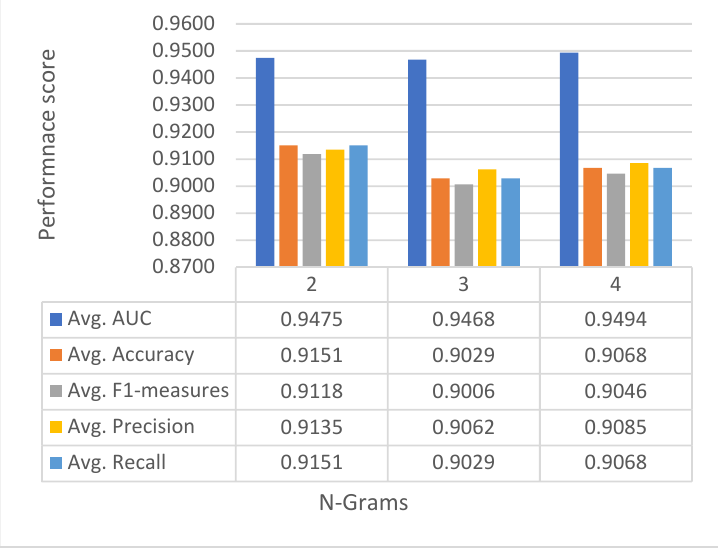
Figure 4. Performance evaluation of the lung ACPs classification with different N-Grams.